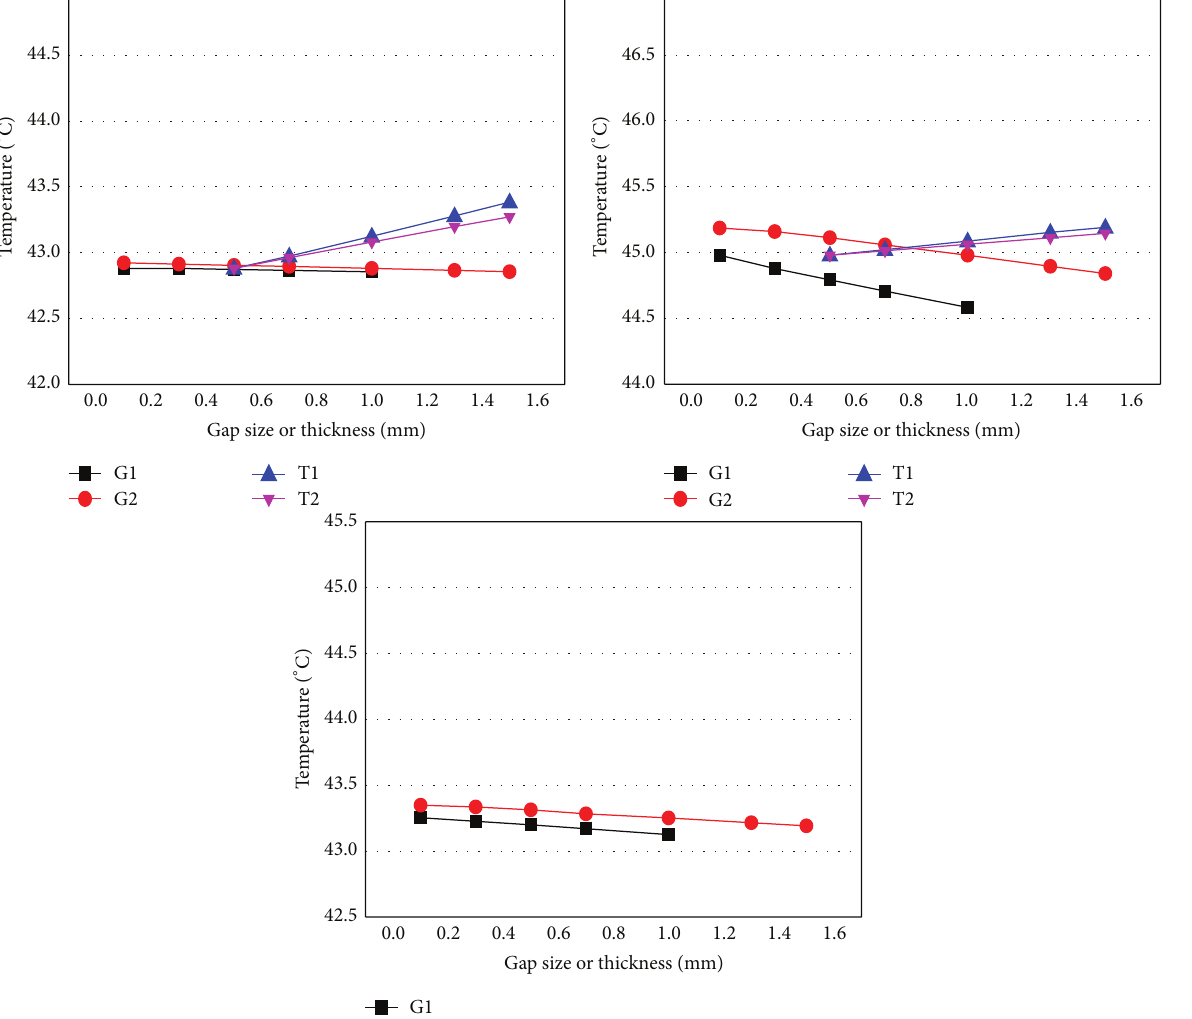
thermal media. Among the 4 variables, the G2 effect is the most significant, and the effects of the others are very small. The steep gradients of the G2 curves indicate that heat is well transferred through thermal media in all cases. While gap G2 varies from 0.1 to 1.5 mm, the temperature of the specimen changes from 150 to 550 ∘ C in NaK, from 300 to 935 ∘ C in LBE, ∘ C in aluminum. Other variables such as and from 140 to 595 G1, T1, and T2 do not have a great impact on the change in specimen